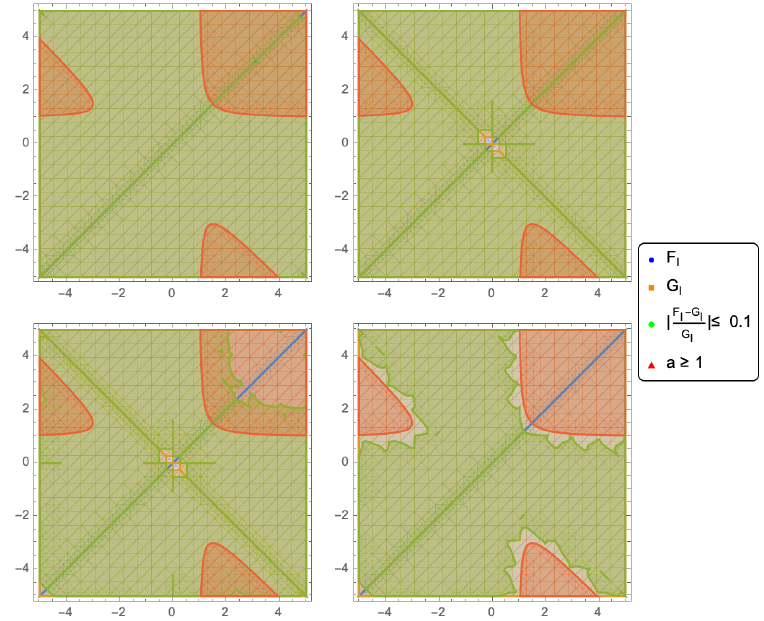
Figure 8: A comparison of the crossing symmetric dispersion for the Photon and Graviton cases which are shown in the first and second rows respectively. We have indicated the regions where F less than 10% in